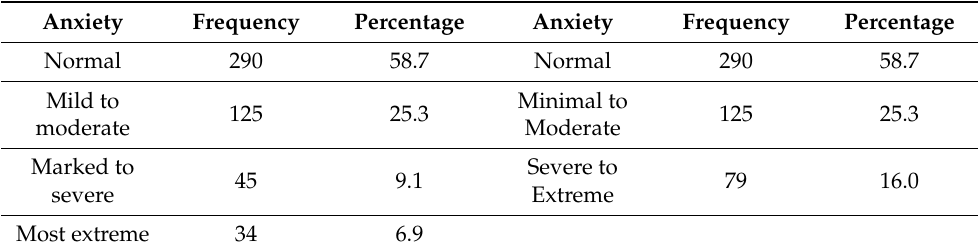
Table 1. Anxiety level based on Zung’s